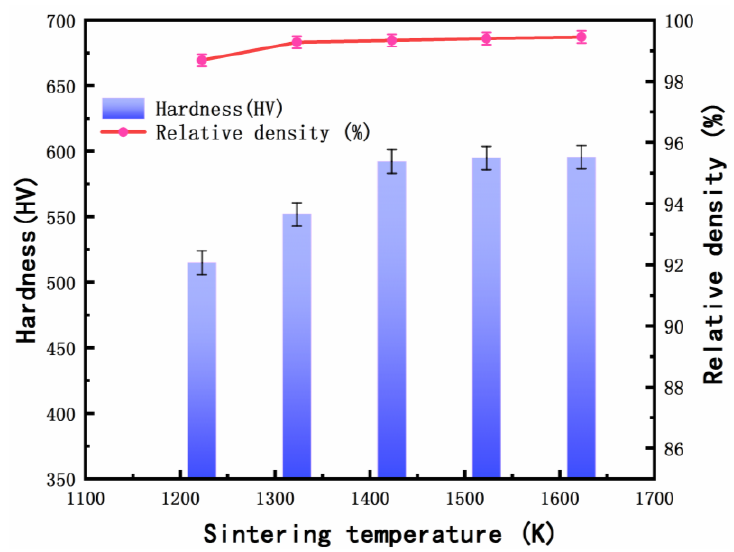
Figure 3. Effect of the SPS temperature on the relative density and hardness of Ti-25Nb-6Zr. Table 1. The relative density and hardness of Ti-25Nb-6Zr alloy at different temperatures. Temperature (K) Hardness